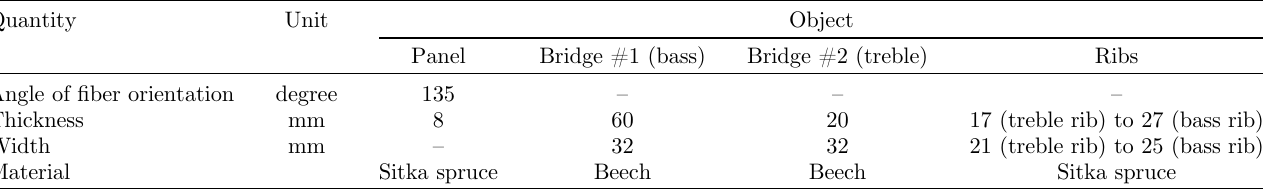
Table 1. Geometric data of the elements of the reference